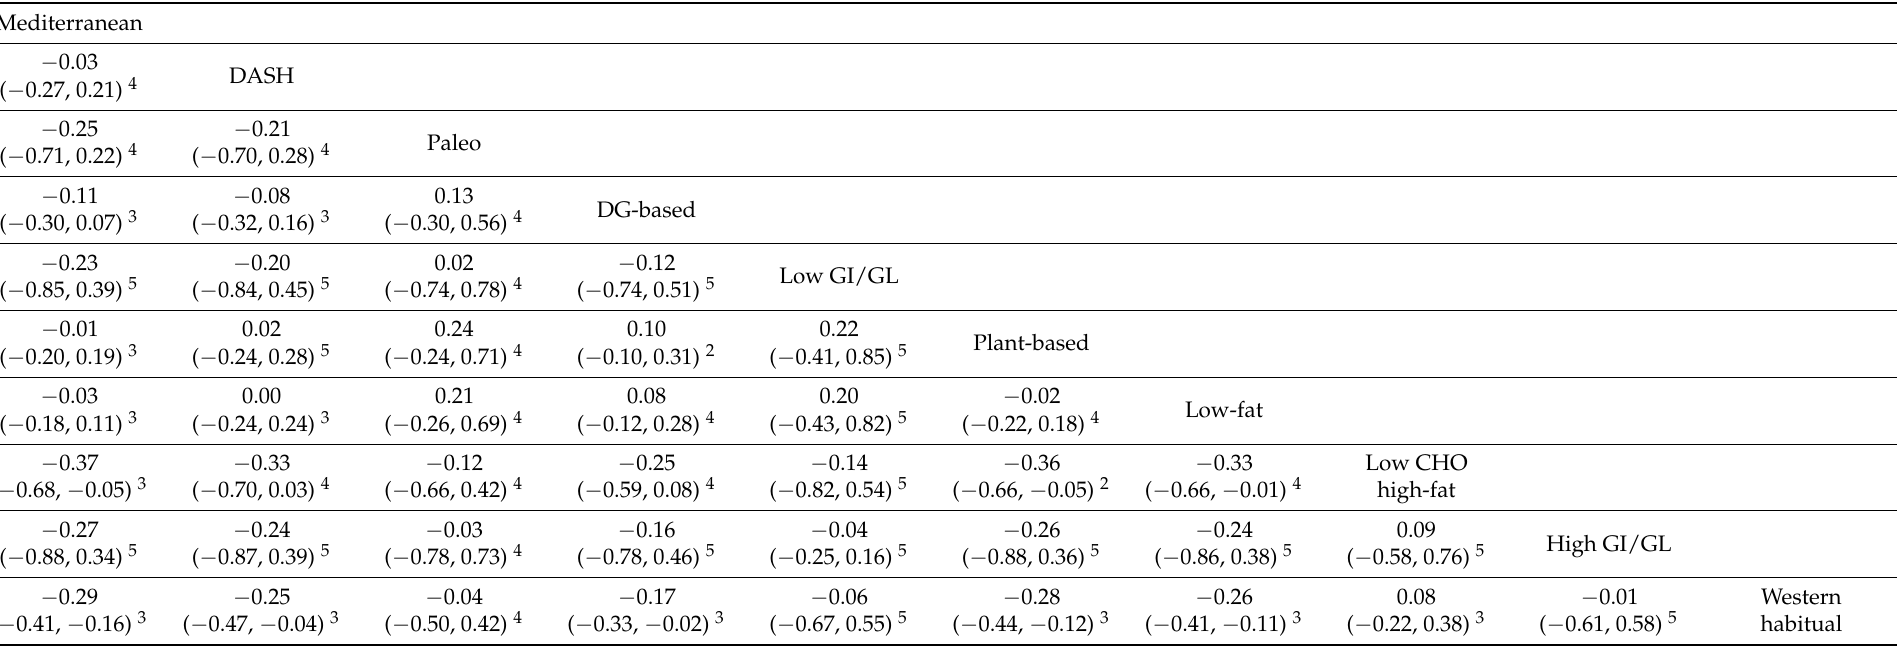
Table 1. League table for LDL cholesterol showing comparative effect sizes between dietary patterns 1